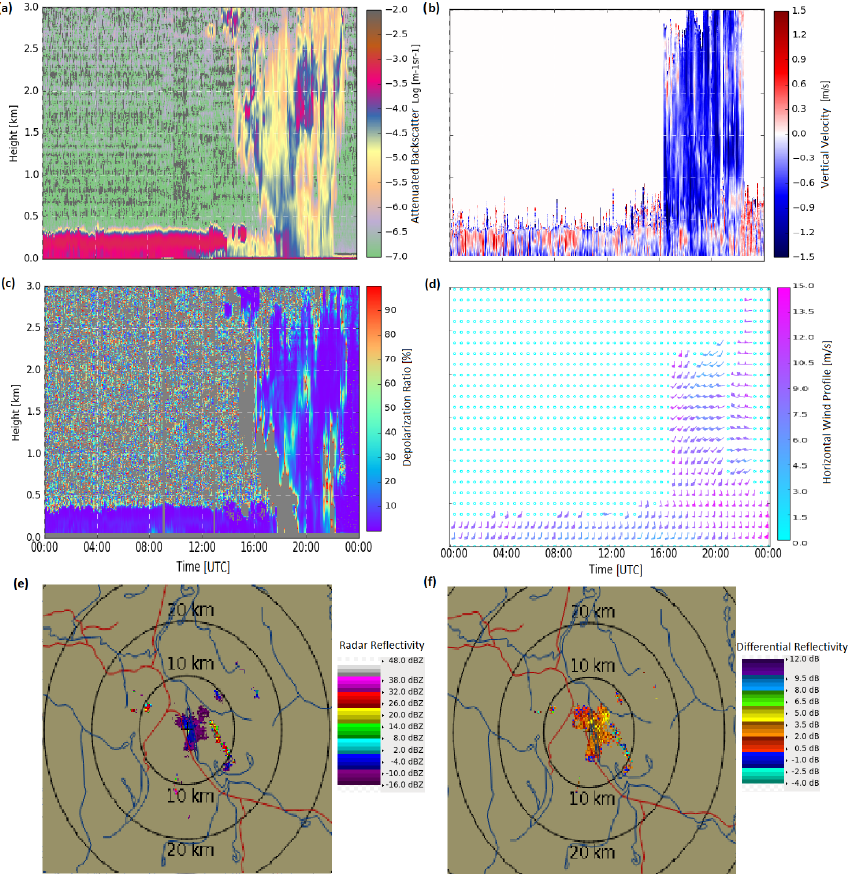
Figure 10. Doppler lidar and X-band radar observations during the HIW event at Whitehorse on 16 December 2019. Doppler lidar vertical profiles of the (a) attenuated backscatter, (b) vertical velocity, (c) depolarization ratio, and (d) horizontal winds are shown. X-band 3.5 ◦ elevation PPI scans of radar reflectivity (e) and differential reflectivity ( Z DR ) (f) provide snapshots of the blizzard in the Whitehorse valley during its peak at